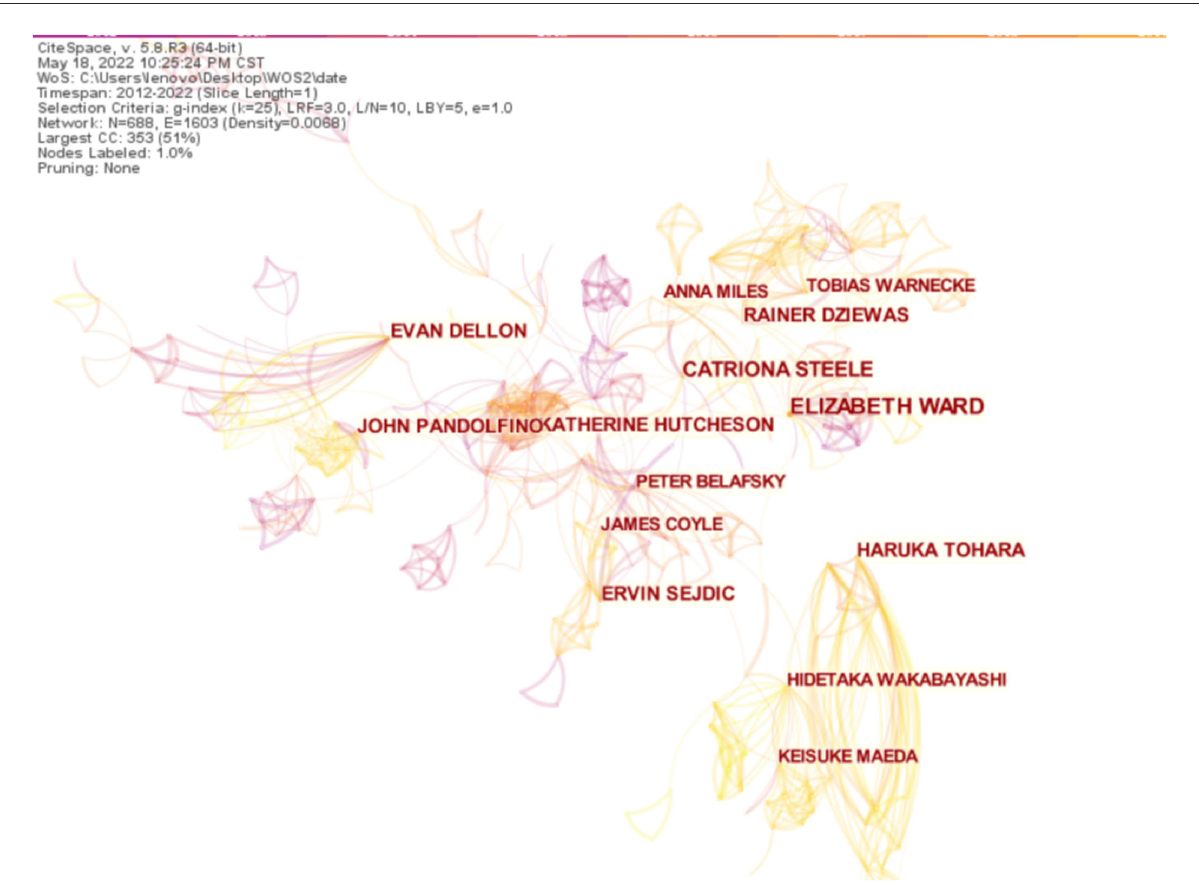
FIGURE6 Map of cited author distribution and cooperative relations on dysphagia from 2012 to 2022. The size of the circle refers to the number of articles published by the author, and the shorter the distance between the two circles, the more the connection between the authors.